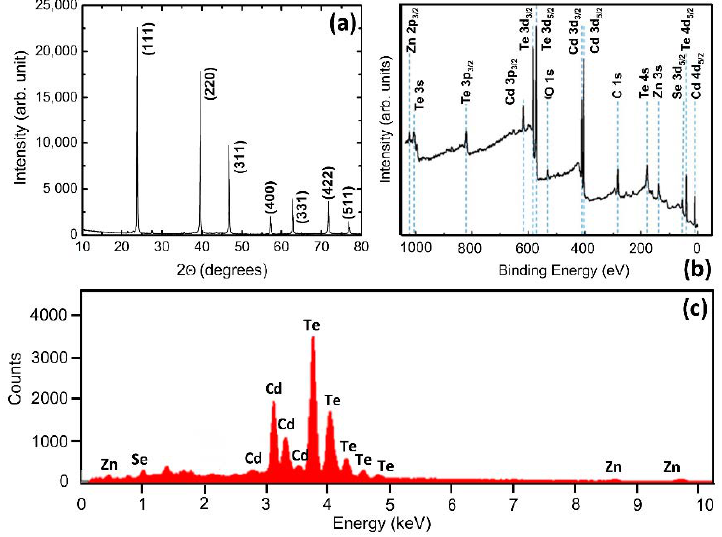
Figure 6. Powder X-ray diffractogram ( a ) survey scan using XPS ( b ) and EDX scan. (Adapted with permission from ref. [49]. Copyright 2021, IEEE) ( c ) of Cd 0.9 Zn 0.1 Te 0.97 Se 0.03 grown using a VBM growth at U of SC.